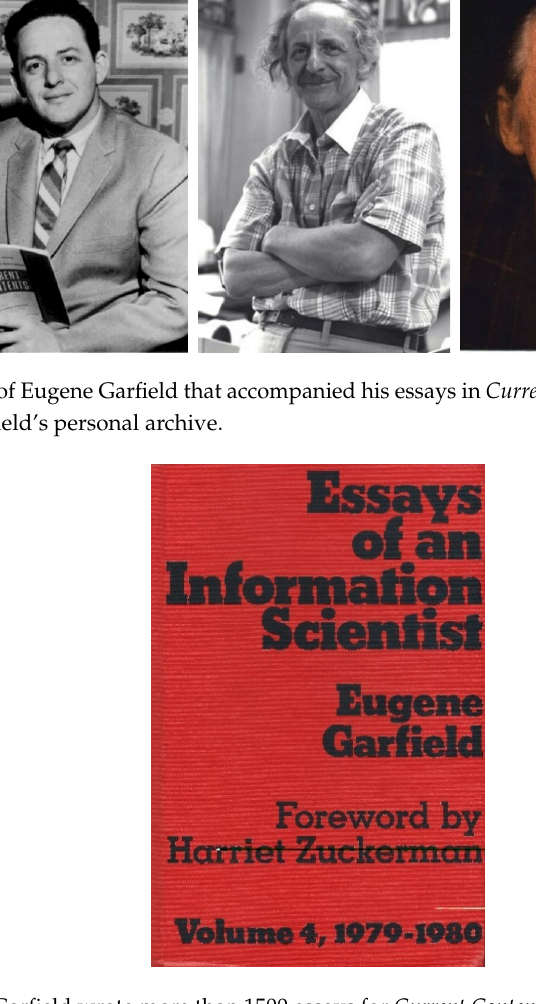
Figure 5. Eugene Garfield wrote more than 1500 essays for Current Contents , which were later collected in a 15-volume series published by ISI